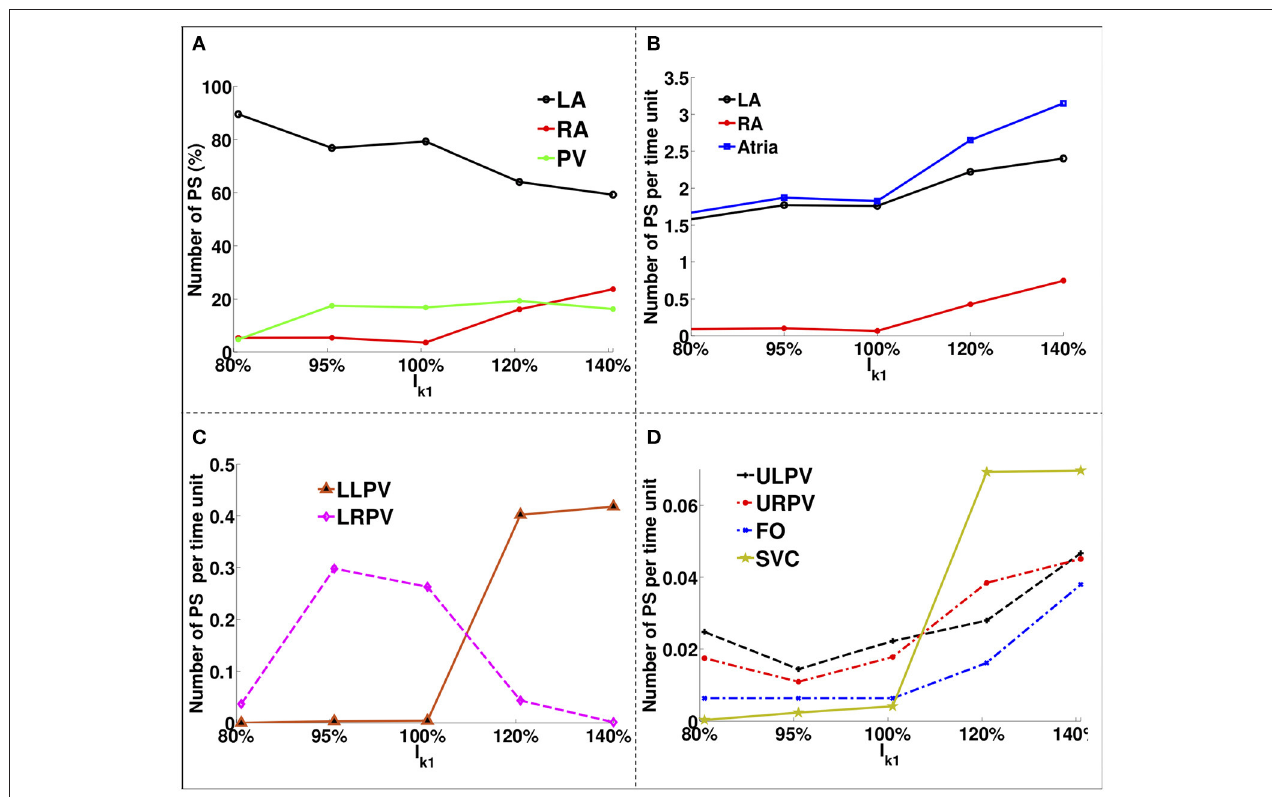
FIGURE 4 | PS location variation as a function of I K 1 for atria with no fibrosis. (A) Percentage of PS locations on the LA body, on the RA and on the PVs. (B) Number of PSs per unit time on the entire LA, on the RA and on the whole atria. (C) Number of PSs per time unit on the LLPV and on the LRPV. (D) Number of PSs per unit time on the ULPV, URPV, FO, and